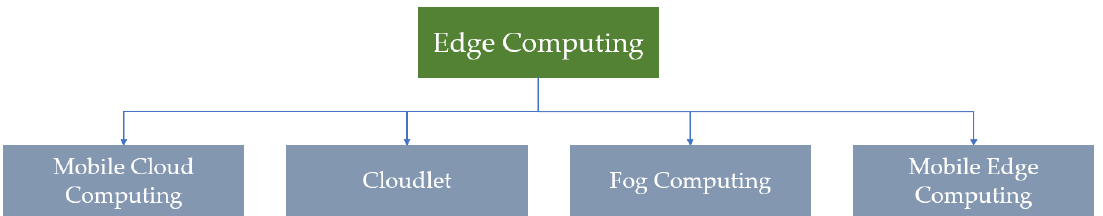
Figure 1. Types of edge computing.